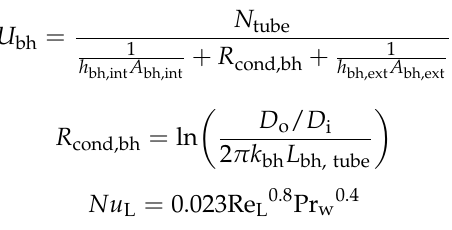
Figure 11. Heat-transfer direction from the water inside the coil heater to the ambient air. In these equations, U amb,3 is the overall heat-transfer coefficient evaluated from the coil heater to the ambient air, A coil,80% is the heat-exchange area between the coil heater and the tank wall (assumed to be 80% of the whole area of the coil heater), R cond,ins is the conductive thermal resistance of the insulator covering the coil heater, SF ins is the shape factor for the insulator, r coil,tube is the radius of the coil tube, D c is the distance from the center of the coil tube to the surface of the insulator, l c is the distance between the two centers of the adjacent coil tube, U ins,s is the overall heat-transfer coefficient at the surface of the insulator, and U amb,2 is the overall heat-transfer coefficient for the heat loss from the fluid in the tank to the ambient air. For the vertical bundle heater inside the bioreactor, the internal and external flow of the heat exchanger was considered. Figure 12 illustrates the heat-transfer interaction for the vertical bundle heater inside the reactor. The thermal analysis for the overall heat-transfer coefficient was based on a single tube. The overall heat-transfer coefficient was multiplied by the number of tubes in the bundle to obtain the heat-transfer rate of the heater, as is shown in Equation (25). The internal and external flow Nusselt number correlations for the convective heat-transfer coefficient were calculated by Equations (27) and (28), respectively [35,40]. Equation (27) is applicable for when 0.6 ≤ Pr ≤ 160, Re ≥ 10,000, and (L/D) ≥ 10. The expression in Equations (29)–(31) shows the parameters that need to be calculated in order to use Equation (28) [40]. Equation (29) can only be used when the fluid flow is in natural convection, and 0.01 ≤ Pr ≤